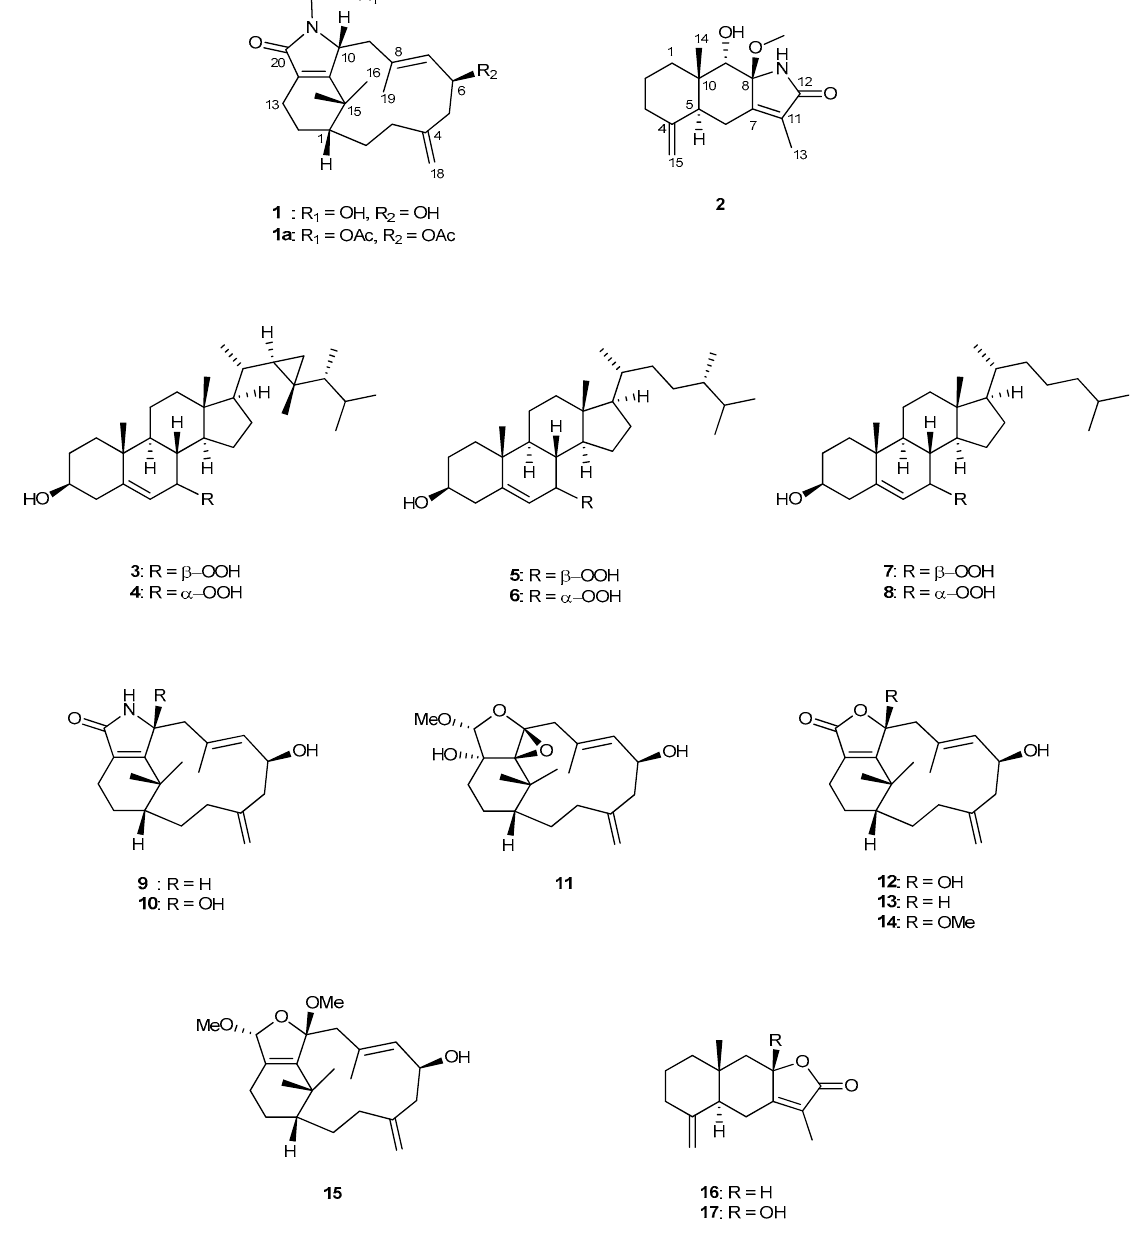
Figure 1. Structures of compounds 1 – 17 . Cespitulactam M ( 1 ) was obtained as an amorphous solid and displayed HRESIMS ( m/z 382.2350 [M + Na] + , calculated for C 22 H 33 NO 3 Na, 382.2353) consistent with the molecular formula C 22 H 33 NO 3 , implying seven degrees of unsaturation. The IR spectrum revealed the presence of amide (1656 cm − 1 ) and hydroxy (3388 cm − 1 ) groups. Subsequently, the 1 H NMR and 13 C NMR spectroscopic data (Tables 1 and 2) demonstrated signals of three methyls, eight sp 3 methylenes, one sp 2 methylene, three sp 3 methines, one sp 2 methine, one sp 3 , and five sp 2 quaternary carbons (including a carbonyl carbon appearing at δ C 172.5 ppm). The above data accounted for four of the seven degrees of unsaturation, resulting in compound 1 with a tricyclic structure. The COSY spectrum, recorded in CDCl 3